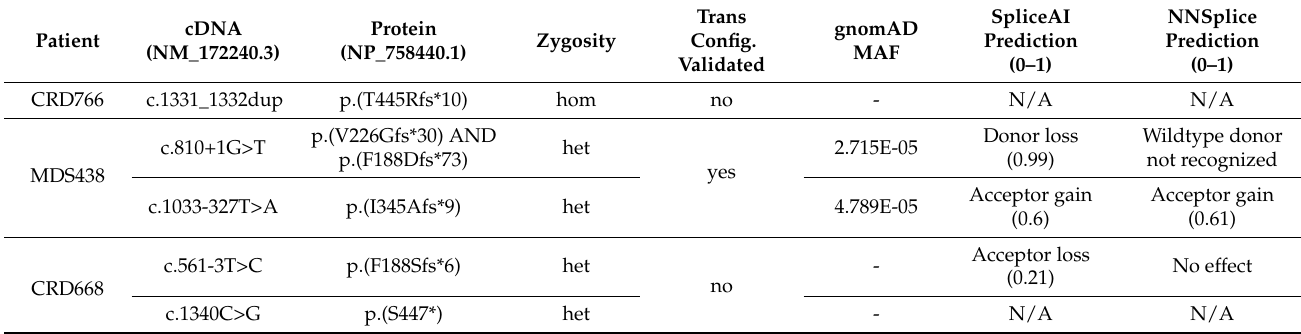
Table 1. POC1B variants identified in this